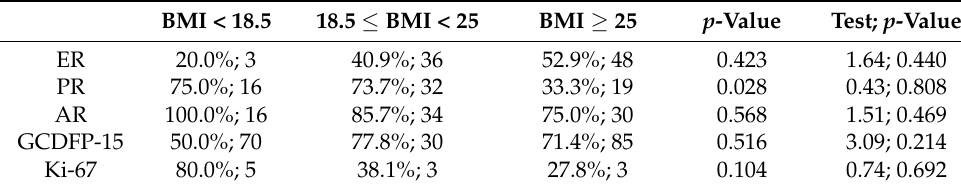
Table 5. Expression of hormone receptors according to